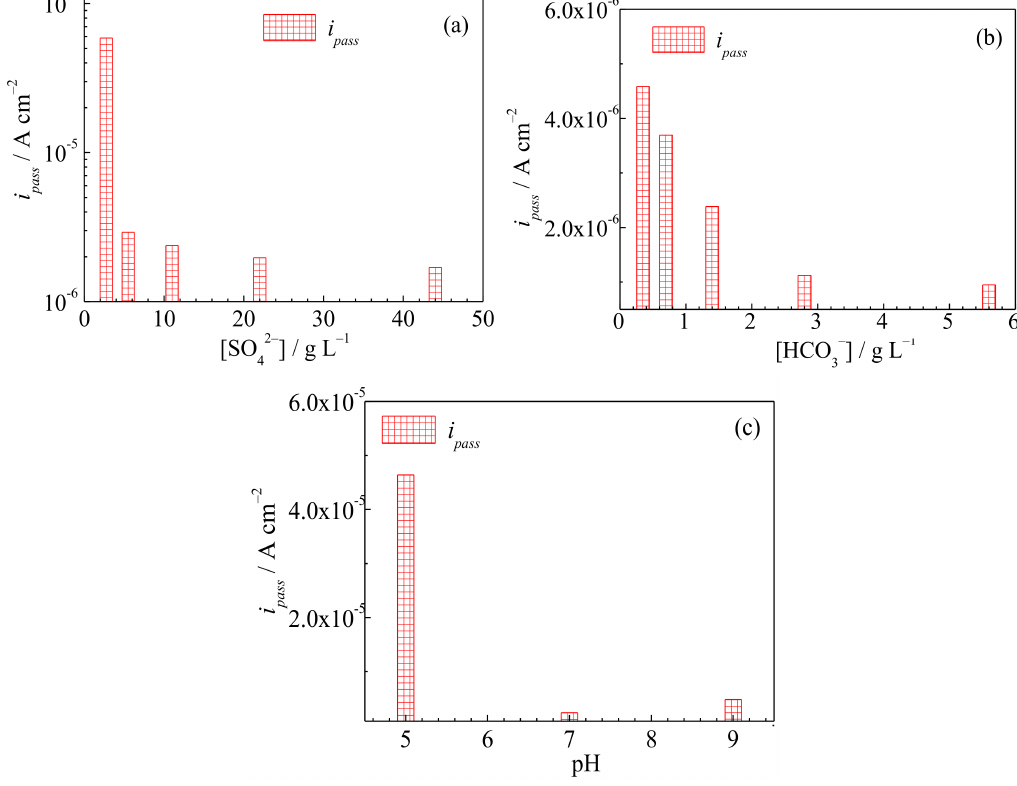
Figure 8. Passive current density of the low-nickel stainless steel in groundwater solutions, ( a ) A1–A5 solutions with different concentration of SO 42 − , ( b ) B1–B5 solutions with different concentration of HCO 3 − , and ( c ) C1–C3 solutions with different pH